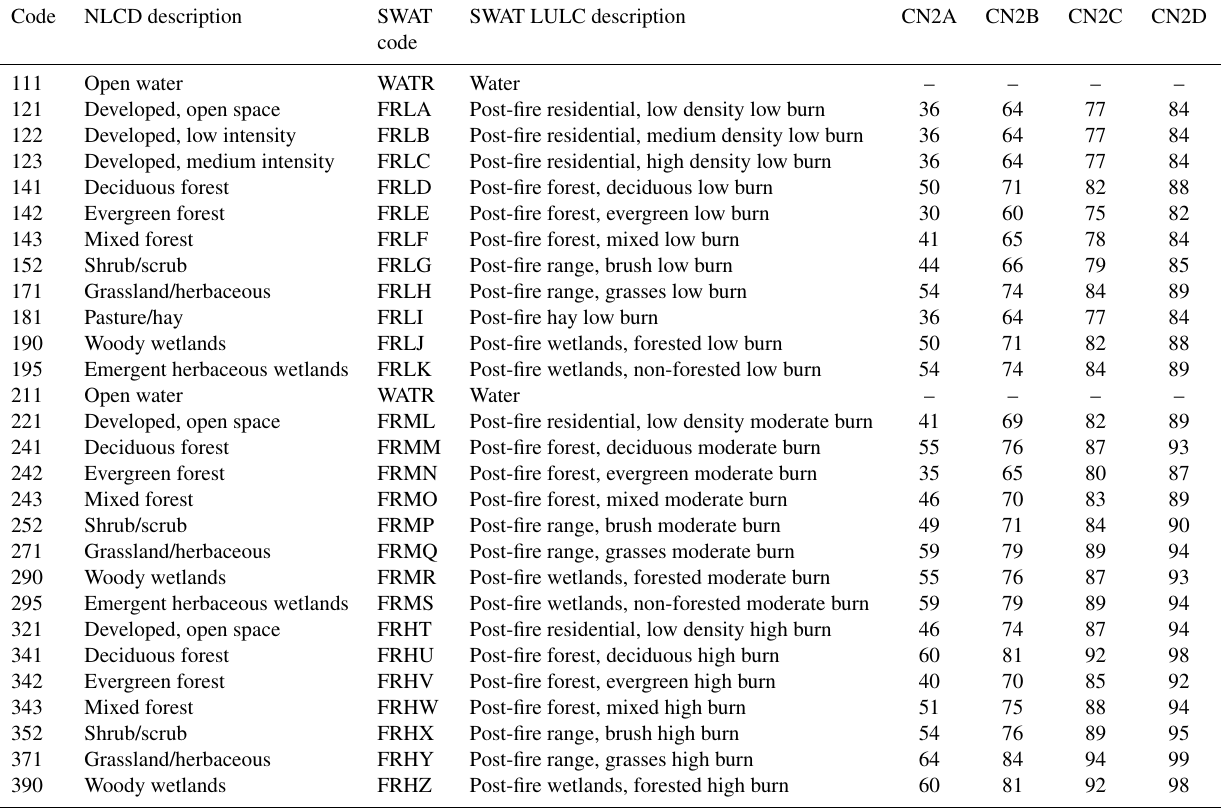
Table A5. Post-wildfire edited lookup table and corresponding curve numbers.